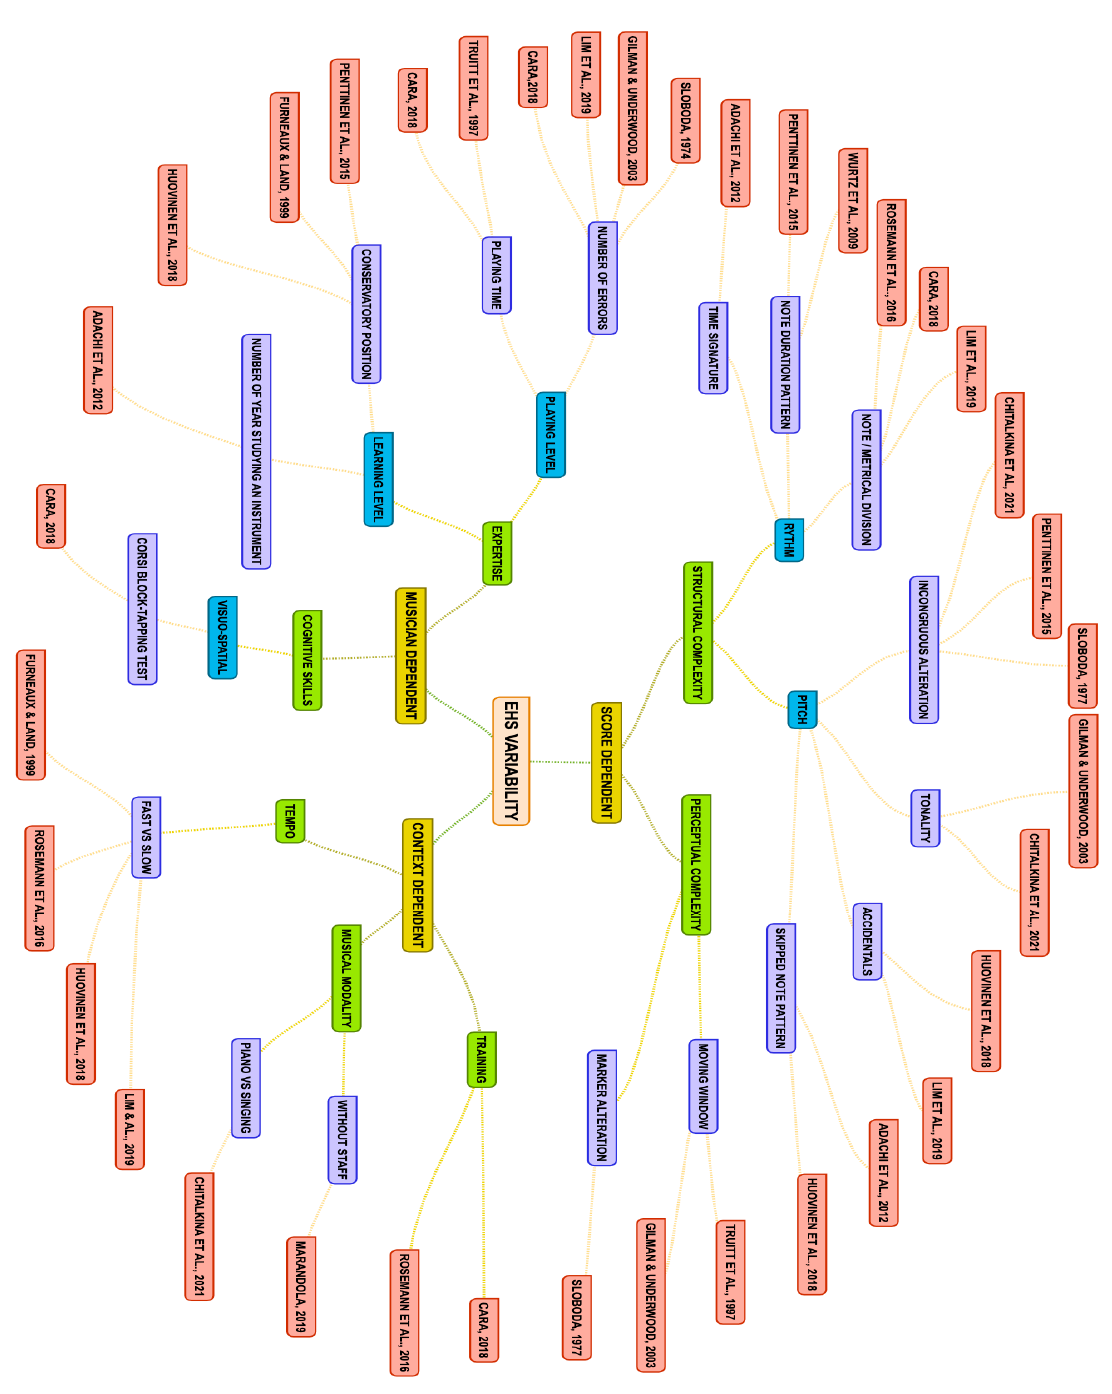
Figure 8: Mind-mapping representation of eye-hand span variability This figure can be read from the inside out. Starting from the central box “EHS variability”, it is possible to follow a path to each study through the type of factor and methodology used. For example, among the studies that varied a score-dependent factor, Lim et al.'s (2019) manipulated the structural complexity of the score by varying its pitch (in this case the number of accidentals in the score). A single study may have manipulated several